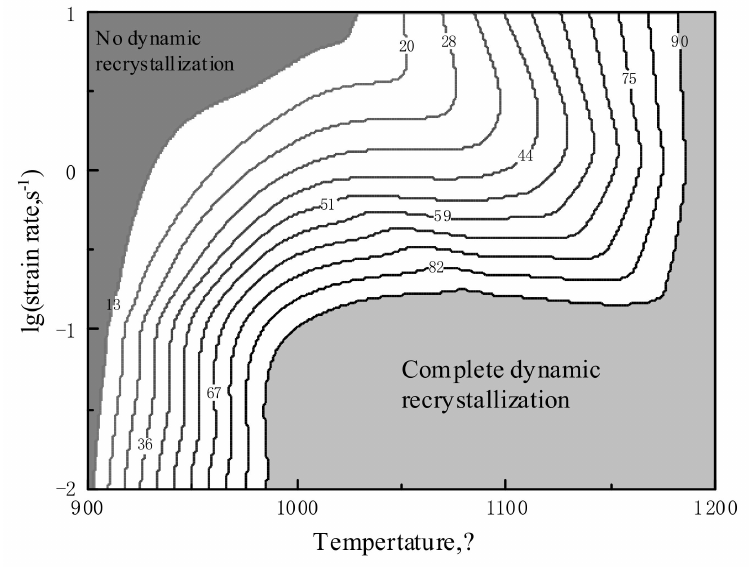
Figure 8. DRX state map of tested